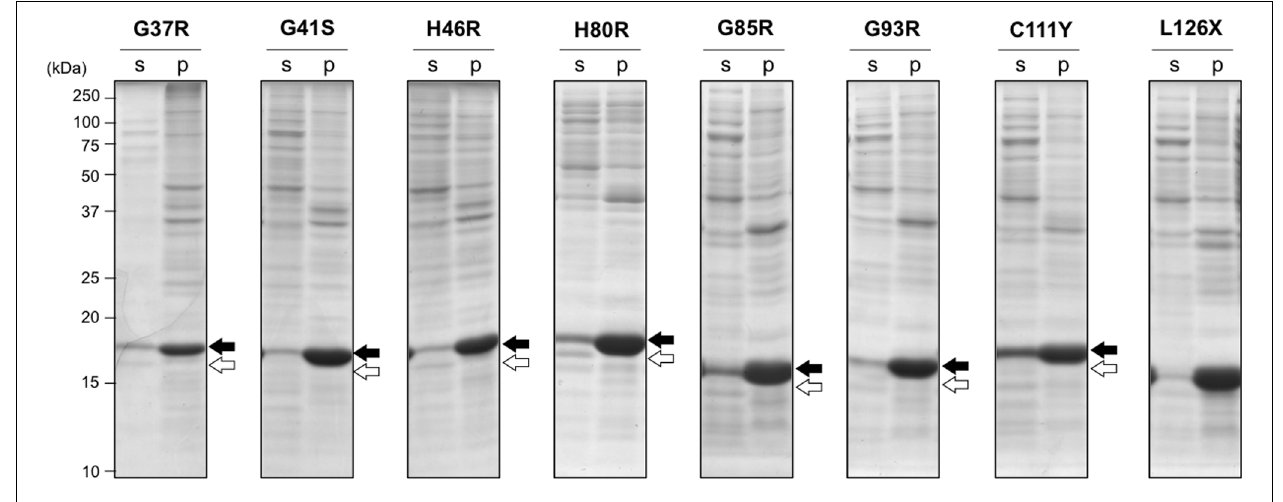
supernatant (s) and insoluble pellets (p), treated with iodoacetamide, and then analyzed with non-reducing SDS-PAGE by using a 15% polyacrylamide gel.White (SOD1 S − S ) and black (SOD1 SH ) arrows at the right side of the gel image indicate positions of bands corresponding to SOD1 with and without a disulfide bond,